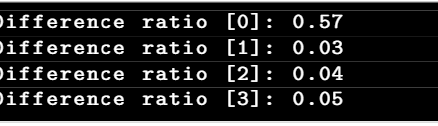
Figure 15. Difference ratios of “change candidates”.